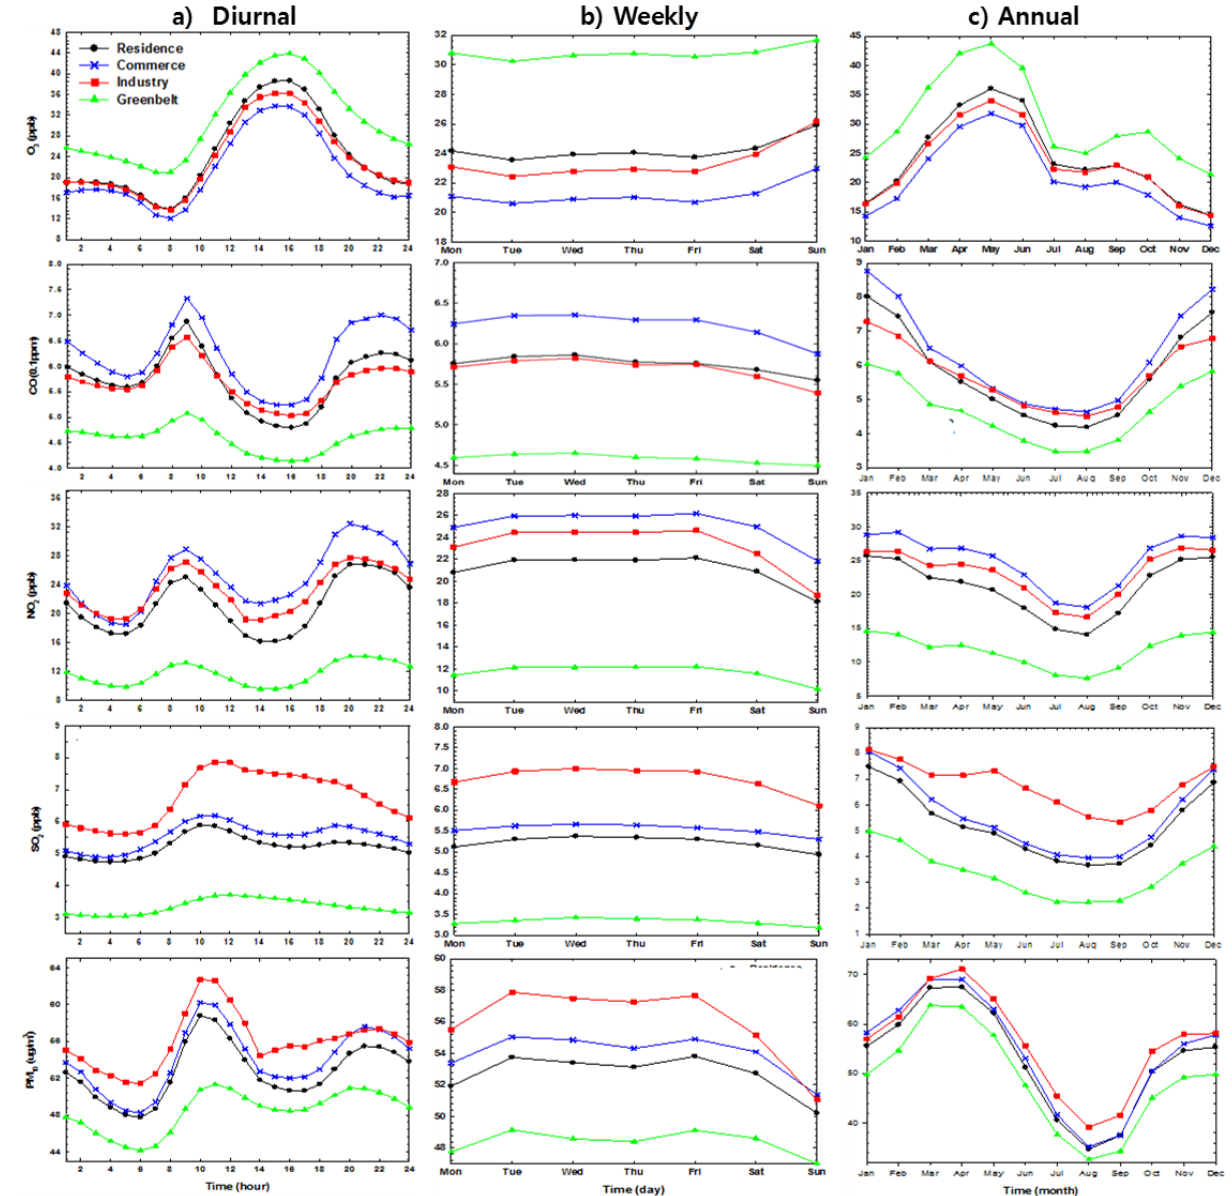
Figure 6. The (a) diurnal, (b) weekly, and (c) annual variations in a 0.25 ◦ × 0.25 ◦ grid of the O 3 (ppb), CO (0.1ppm), NO (ppb), SO 2 , (ppb) and PM 10 (µgm − 3 ) observations over South Korea during 2002–2013 under the MEK four land-use types as follows: residence (black circle), commerce (blue cross), industry (red square) and greenbelt (green